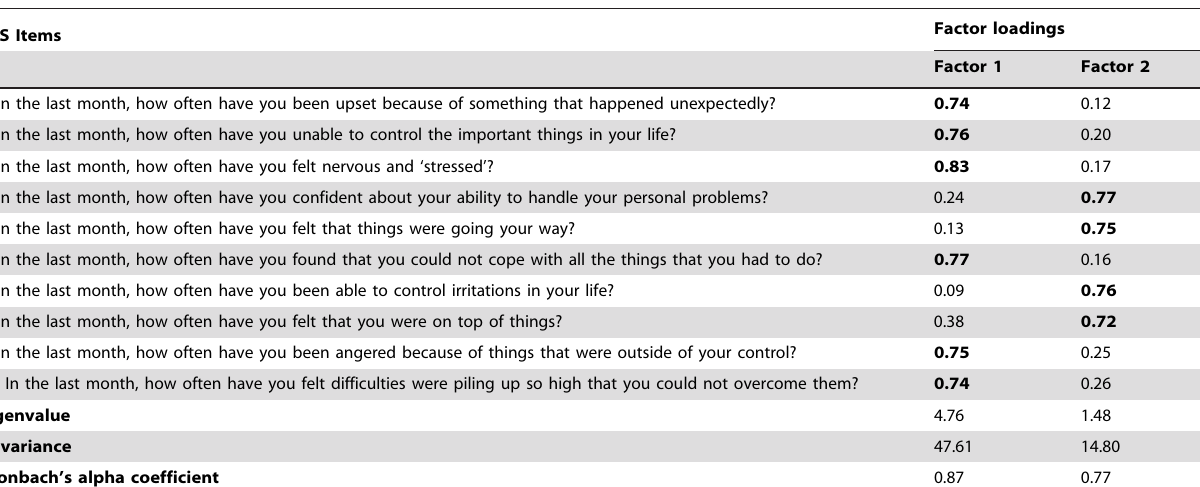
Table 1. Exploratory factor analysis and reliability coefficients of PSS-10 (n=120).